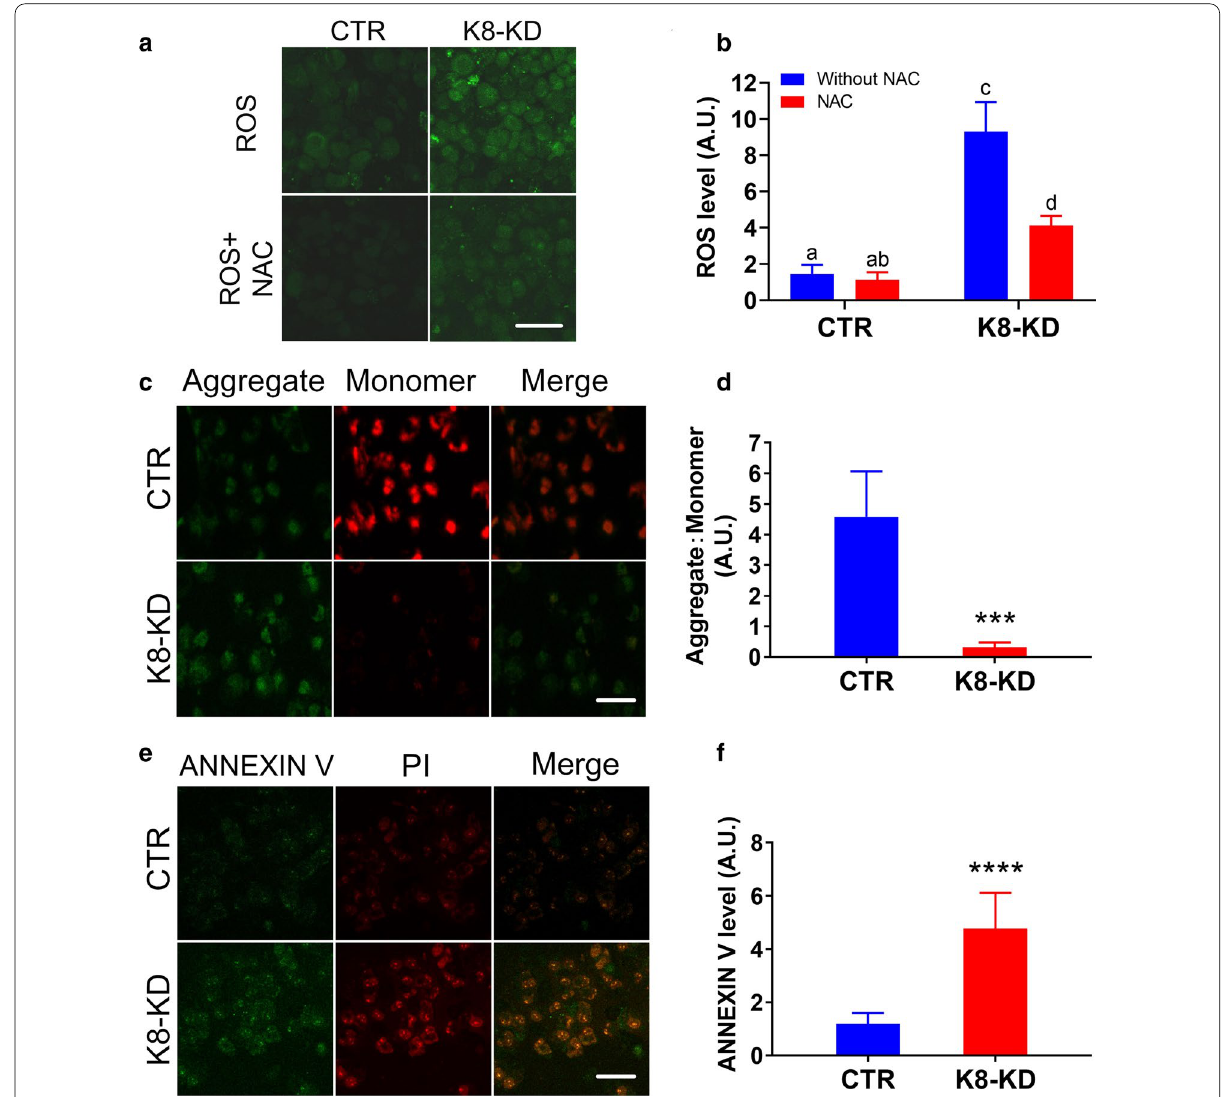
Fig. 5 Human KBTBD8 was important for the general health state of EOC cells. a , b KBTBD8 knockdown significantly increased ROS level in A2780 ovarian cancer cells with or without NAC (ROS level without NAC, CTR vs. K8‑KD, 1.458 vs. 9.313; ROS level with NAC, CTR vs. K8‑KD, 1.125 vs. 4.125). c , d JC‑1 staining assay showed that the mitochondria membrane potential significantly decreased after the KBTBD8 knockdown (Aggregate: monomer, CTR vs. K8‑KD, 4.580 vs. 0.3118). Aggregate in green, monomer in red. e , f Annexin V staining assay showed that KBTBD8